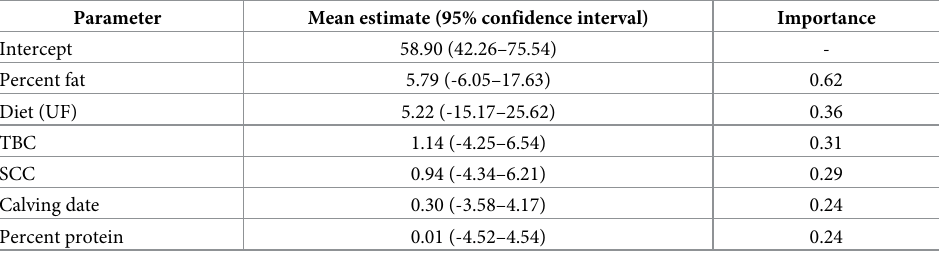
Table 1. Mean LMM estimates of multi-model inference parameters of raw milk microbiota composition.